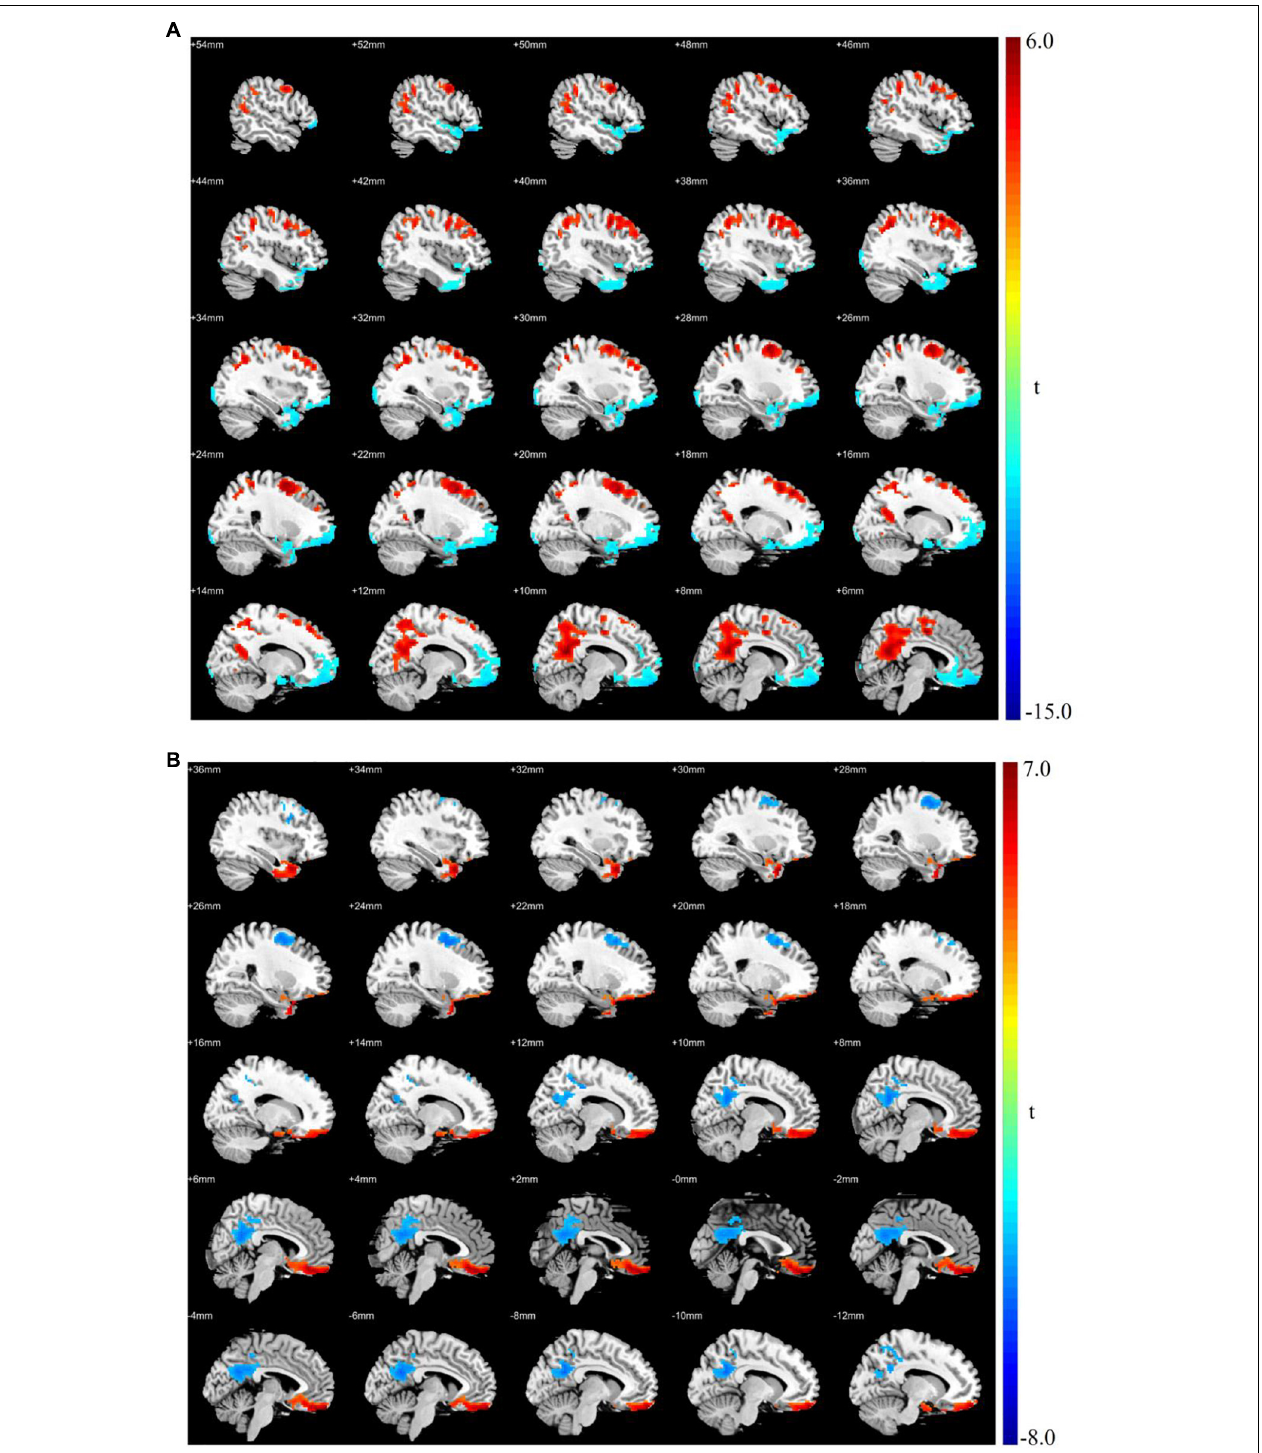
FIGURE 1 | (A) Brain regions showing significant differences of amplitude of low-frequency fluctuation (ALFF) between MDD and healthy controls. (B) Brain regions showing significant differences of ALFF between pre- and post-rTMS. The warm color denoted the region where ALFF is higher, and the cool color denotes the region where ALFF is